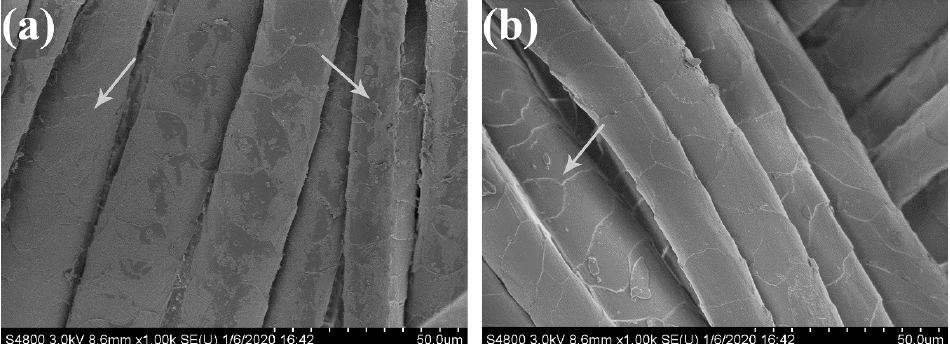
Figure 8. SEM of modified pigments ( a ) and the dye Acid Blue 93 ( b ).